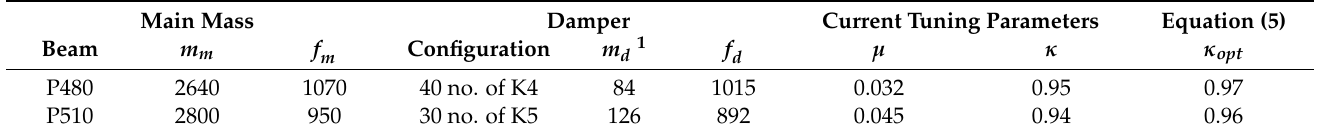
Table 8. Tuning the core-coating